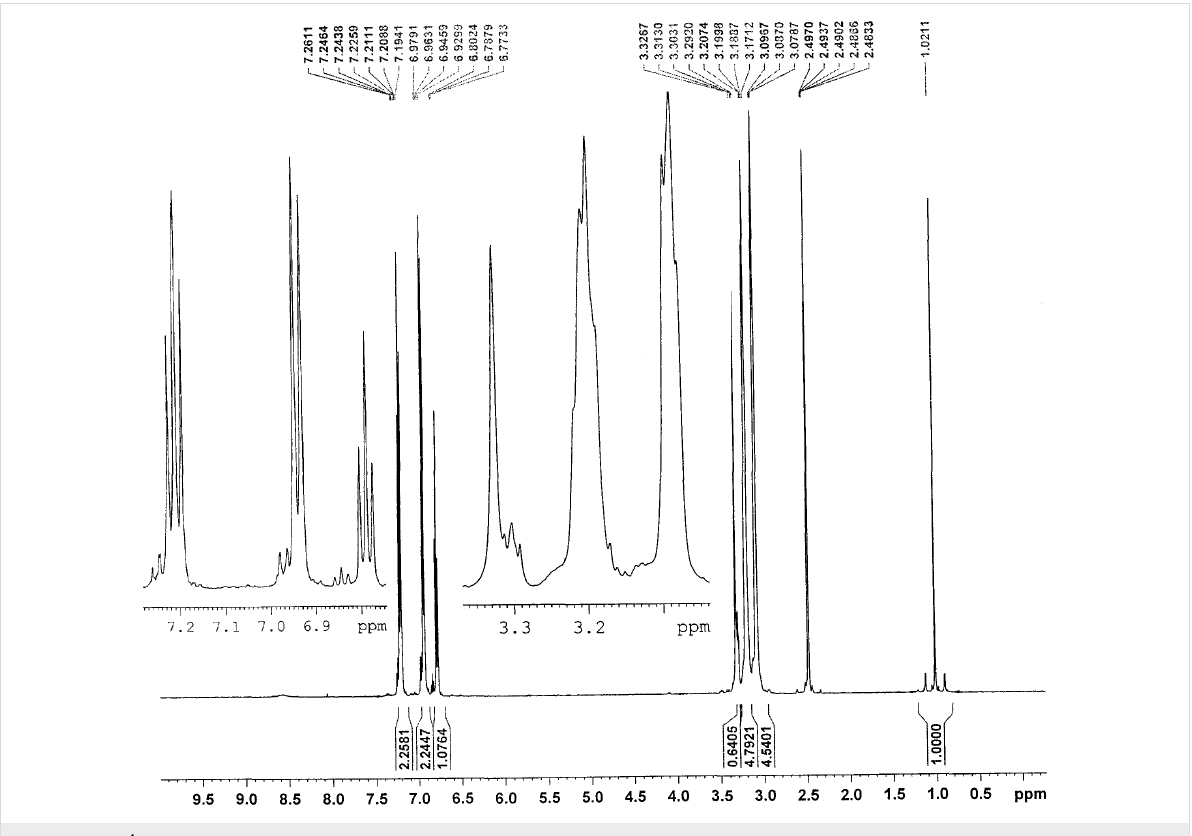
Figure 2: The 1 H NMR spectrum of compound 4 .